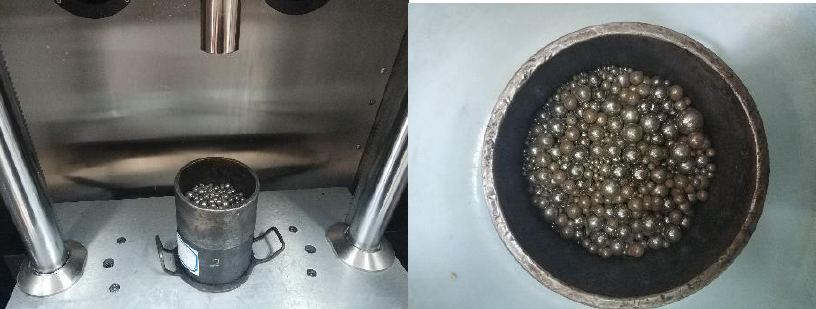
Figure 10. Steel balls in lab experiment.